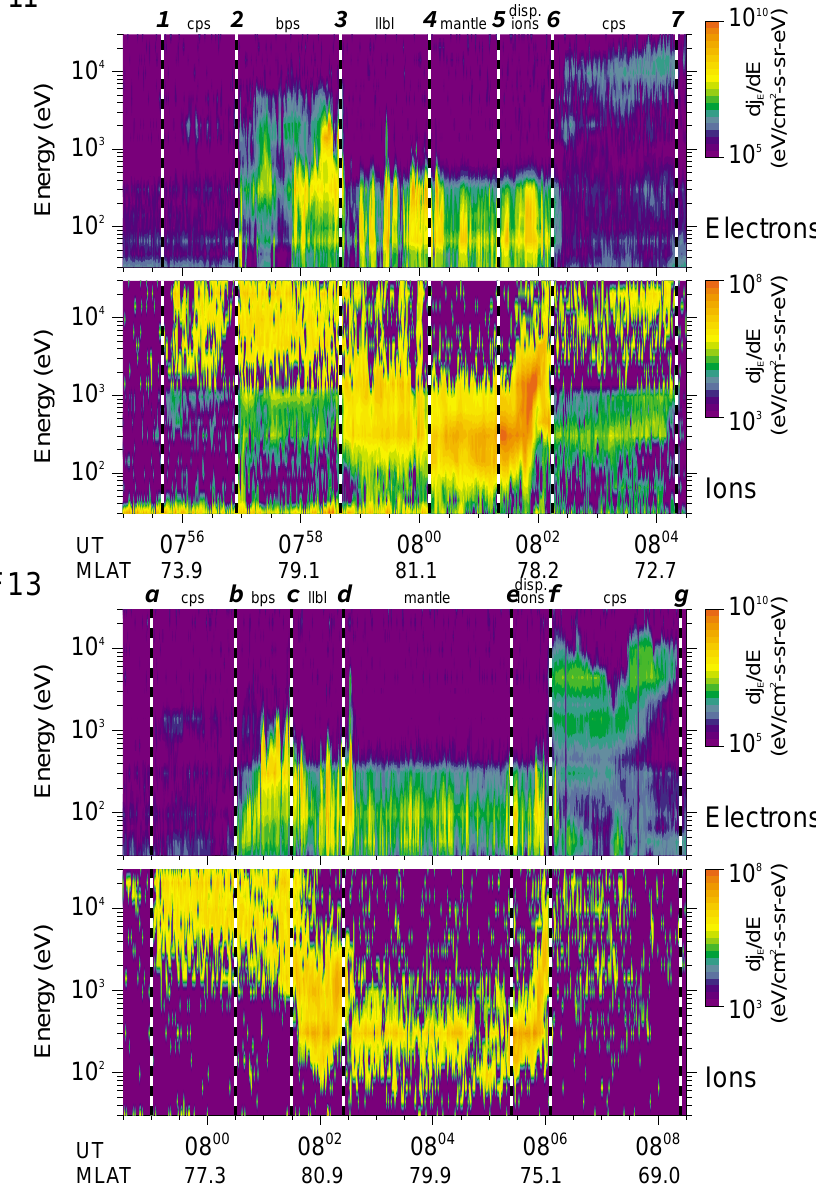
Fig. 2. The ion and electron spectro- grams for the F11 DMSP low-altitude spacecraft for the time interval 07:55 to 08:04:30UT, and for the F13 spacecraft for the interval 07:58 to 08:08:30UT for 16 September